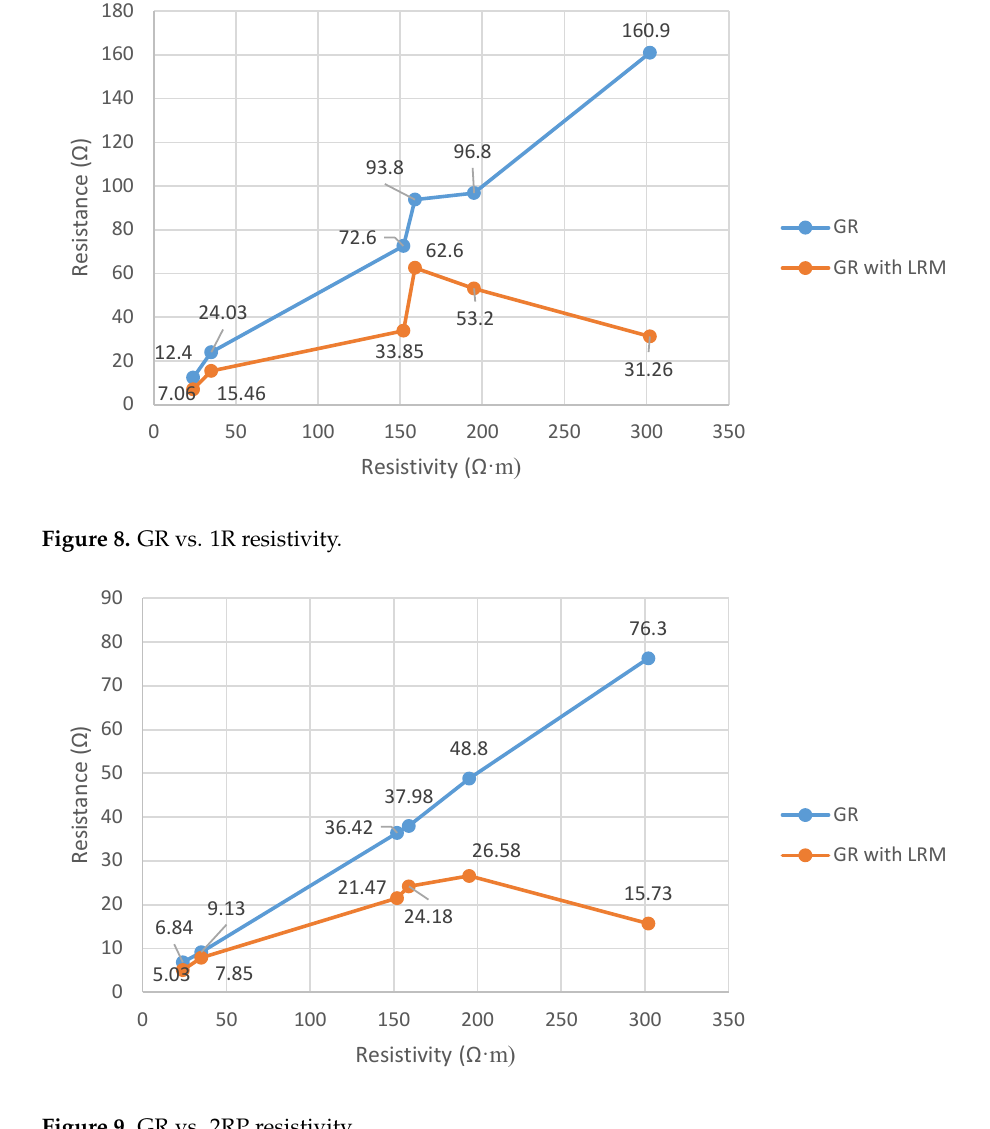
Figure 9. GR vs. 2RP